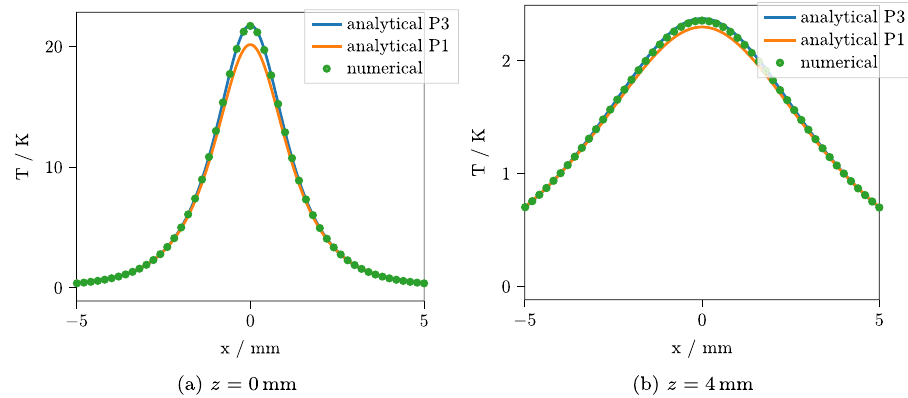
0 for two different 0 ◦ along the line y = =